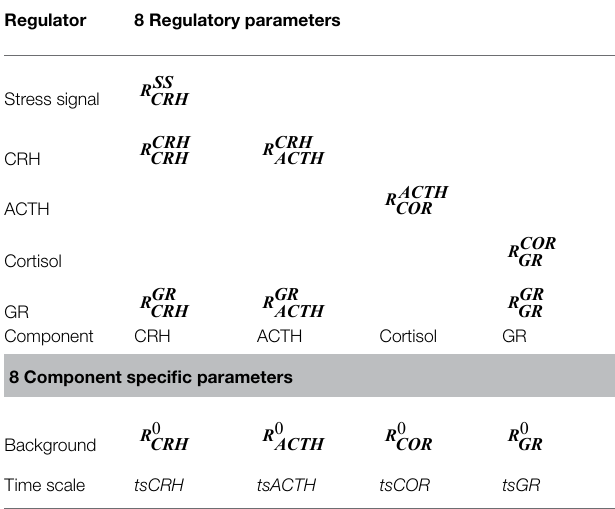
TABLE 1 | The matrix of model parameters.